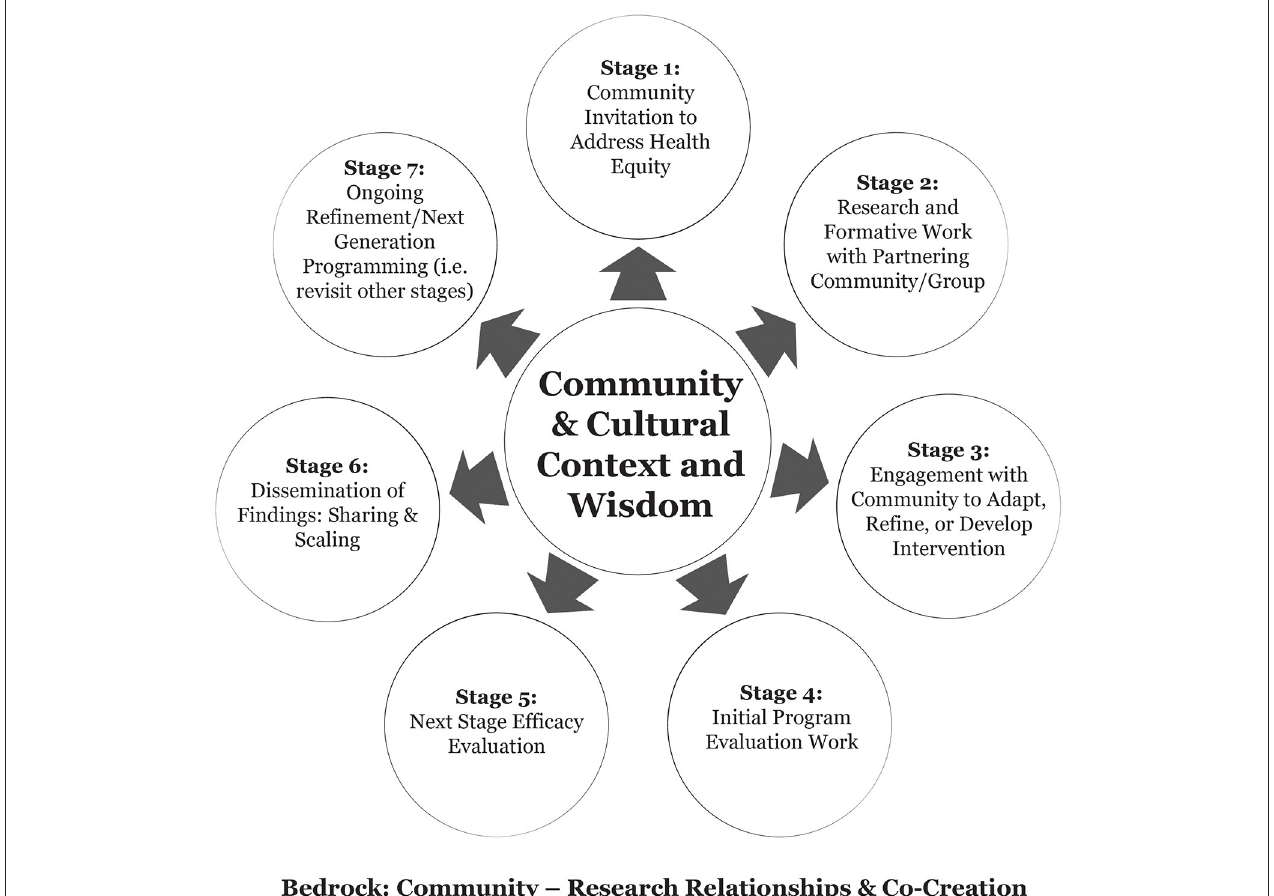
FIGURE 1 | A stage-based model of tribally-based intervention development and evaluation.